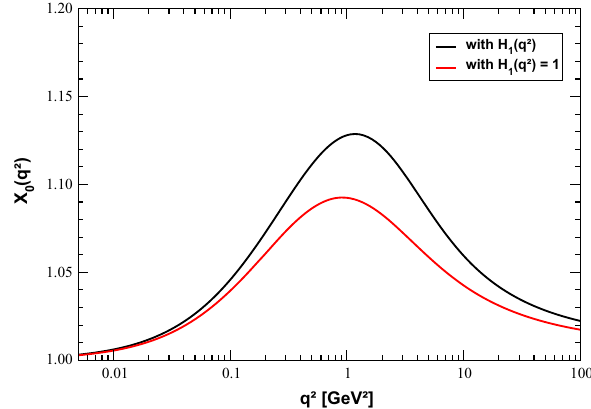
Fig. 12 Simplifiedone-loopdressedperturbationtheoryestimationfor X 0 ( q 2 )